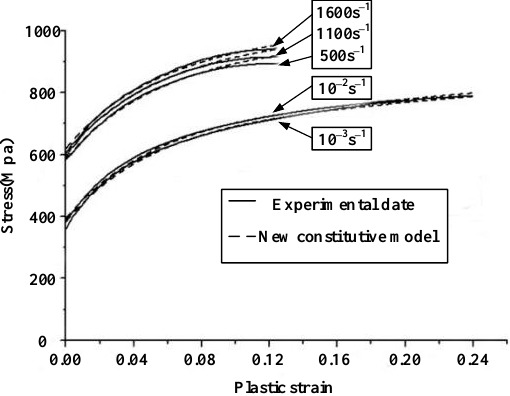
Figure 6. Comparison of the new constitutive model prediction data and experimental data [17]. Khan and Liang [18] modified the relationship between 𝐽 2 and 𝐷 2𝑃 in the original KH model by considering the influence of temperature effect on the mechanical properties of materials, and established a new KHL constitutive model, as shown in Equation (18):